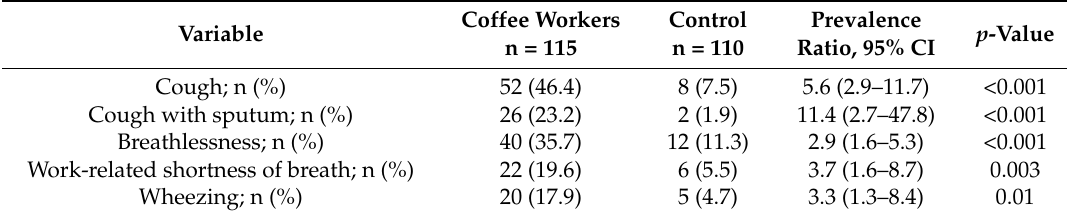
Table 2. Prevalence of chronic respiratory symptoms among coffee workers and controls.